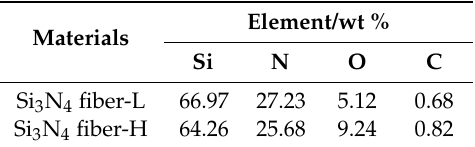
Table 2. Elemental analysis of Si 3 N 4 fibers following annealing.